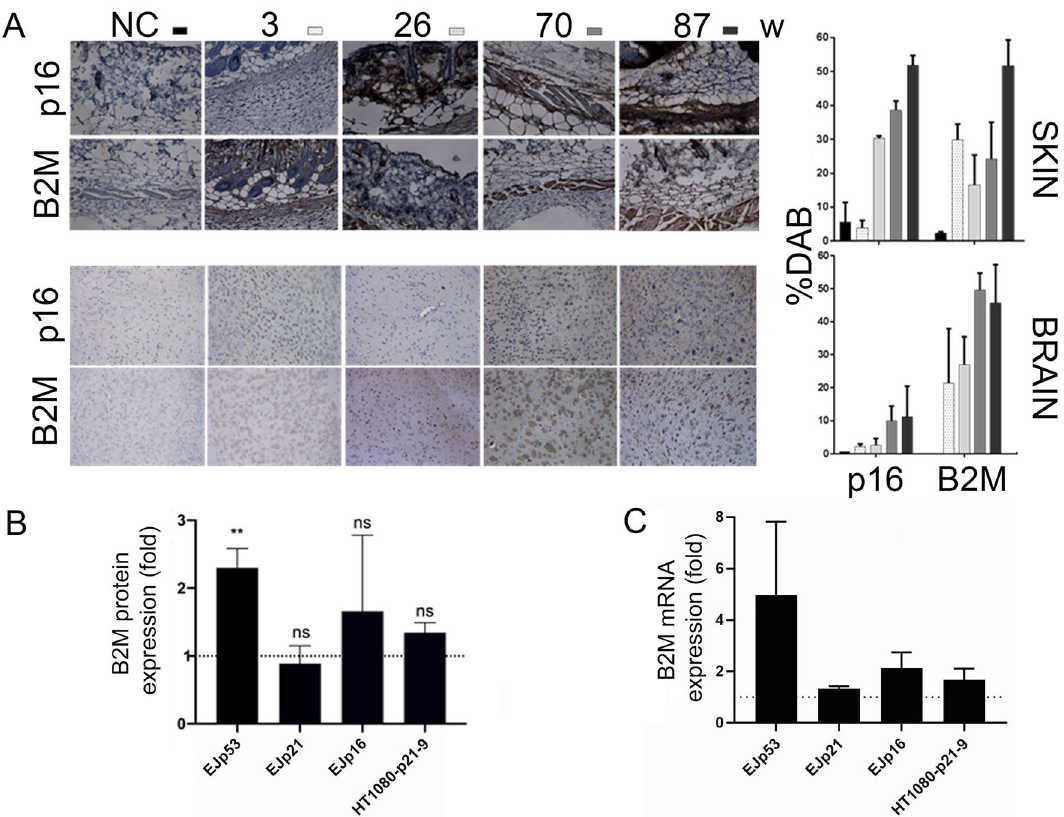
Figure 1. B2M expression increases with age in mice. ( A ) Representative images of i mmunohistochemical staining (left) of skin and brain (frontal lobe) samples from mice of different ages (3–87 weeks), showing B2M expression, as compared to p16 (senescence marker) Magnification: × 20. Graphs show quantitation of expression as %DAB (right). Bars represent the average of three independent samples for skin and five for brain, error bars represent standard deviation (SD). Fold change quantifications of B2M protein ( B ) and mRNA ( C ) expression levels, as measured by Western blot and quantitative real-time PCR, respectively, in EJp53, EJp21, EJp16 and HT1080-p21-9 cells induced to senesce for 4 days, normalized to the expression of their proliferating counterparts (represented by the dotted line at y = 1). Bars represent the mean ± SD of 3 independent experiments. ** p < 0.005 (compared to proliferating